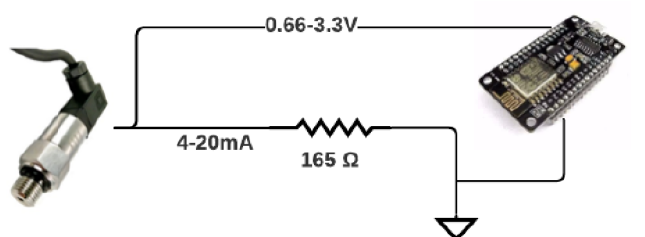
Figure 6. Conditioning circuit for pressure measurement by ESP8266. Source: